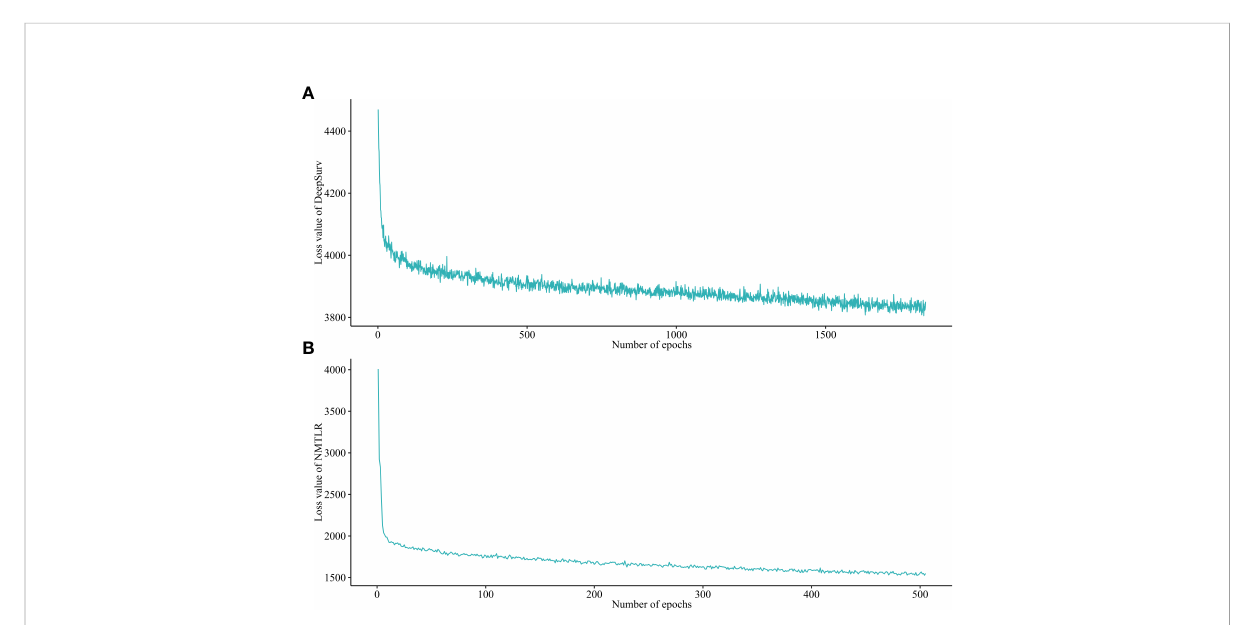
FIGURE 3 Loss convergence graph for (A) DeepSurv, (B) neural network multitask logistic regression (N-MLTR)